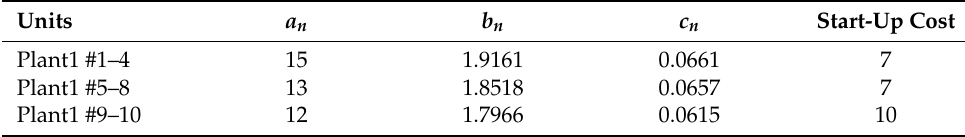
Table 3. Diesel generator cost factor and startup